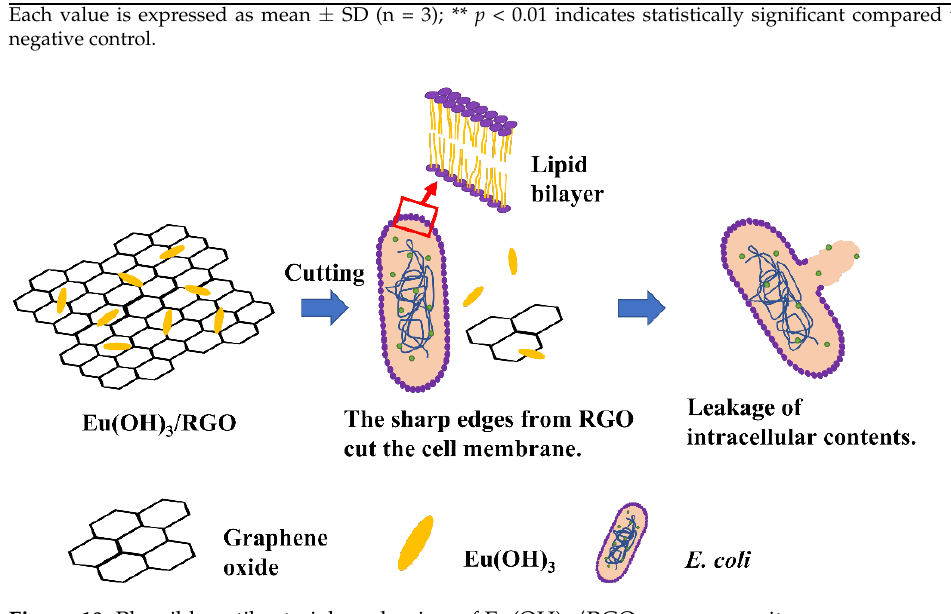
Table 3. Diameter (± standard deviation, SD) of 150 µL of the E. coli (10 4 CFU/mL) inhibitory zone . Table 3. Diameter ( ± standard deviation, SD) of 150 µ L of the E. coli (10 4 CFU/mL) inhibitory zone. Zone of Inhibition (Diameter ± SD (mm)) Zone of Inhibition (Diameter ± SD (mm)) Ampicillin RGO Eu(OH) 3 Eu(OH) 3 /RGO Ampicillin RGO Eu(OH) 3 Eu(OH) 3 /RGO E. coli